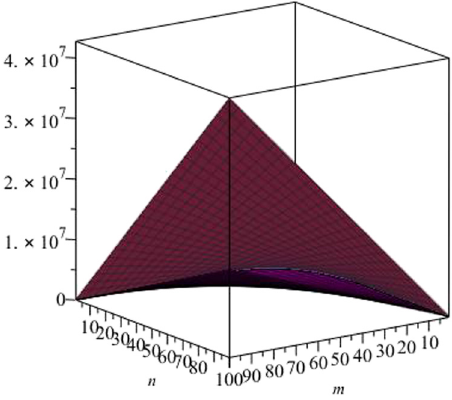
Figure 3: Comparison of K - Banhatti B 1 and K - Banhatti B 2 indices.